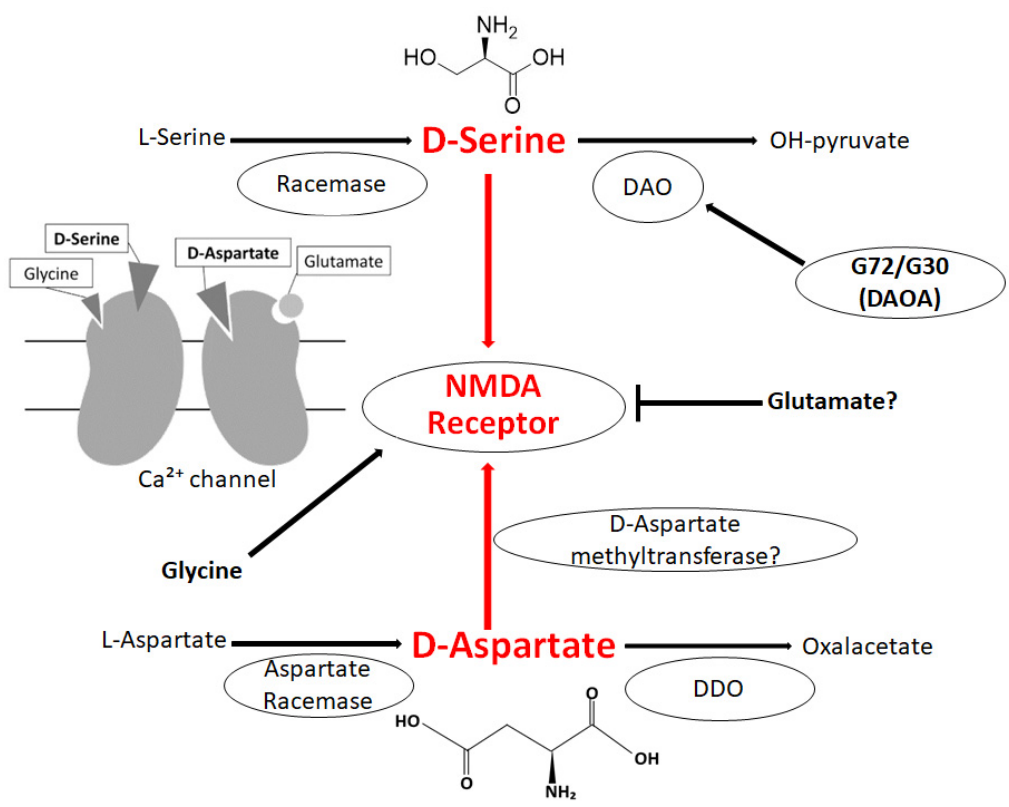
Figure 1. Illustration of the general D-Serine or D-Aspartate metabolic pathway in bacteria and/or in mammals. D-Amino acid oxidase (DAO) catalyzes the oxidative deamination of D-Serine. The DAO activator G72/G30 could stimulate the DAO. Both D-Serine and D-Aspartate are involved in NMDA receptor signaling in the neuron. The arrowhead means stimulation and/or augmentation, whereas the hammerhead represents inhibition. As a footnote, some serious events have been omitted for simplicity. DDO: D-Aspartate oxidase; DAOA: DAO activator; NMDA: N-methyl-D-aspar- tate.